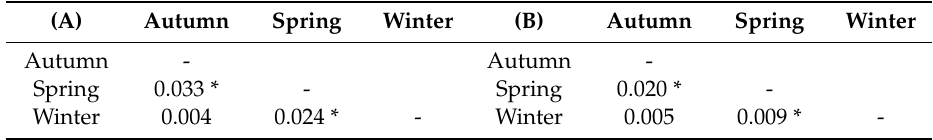
Table 6. Assessment of the genetic di ff erentiation by the season sampled in M. persicae aphids. The fixation index Fst was computed using ( A ) all clonal copies per multilocus genotype or ( B ) one single copy.